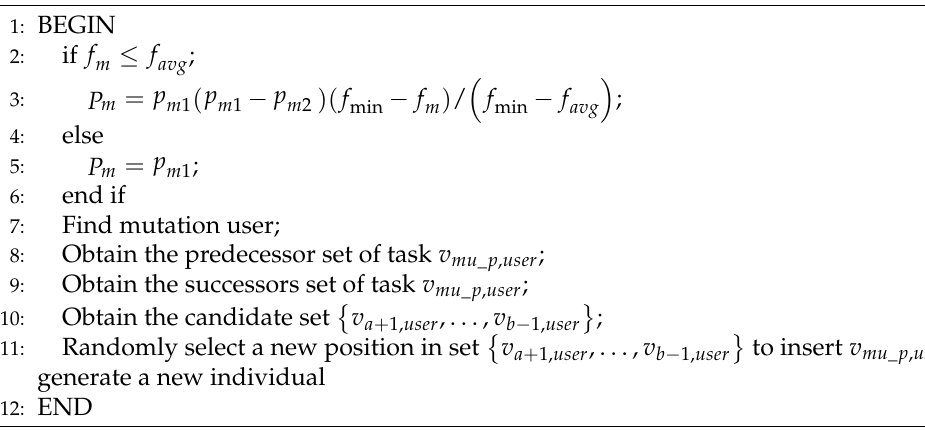
Figure 8. Task execution order single − point mutation operation. Algorithm 4 Single-point mutation for task execution order